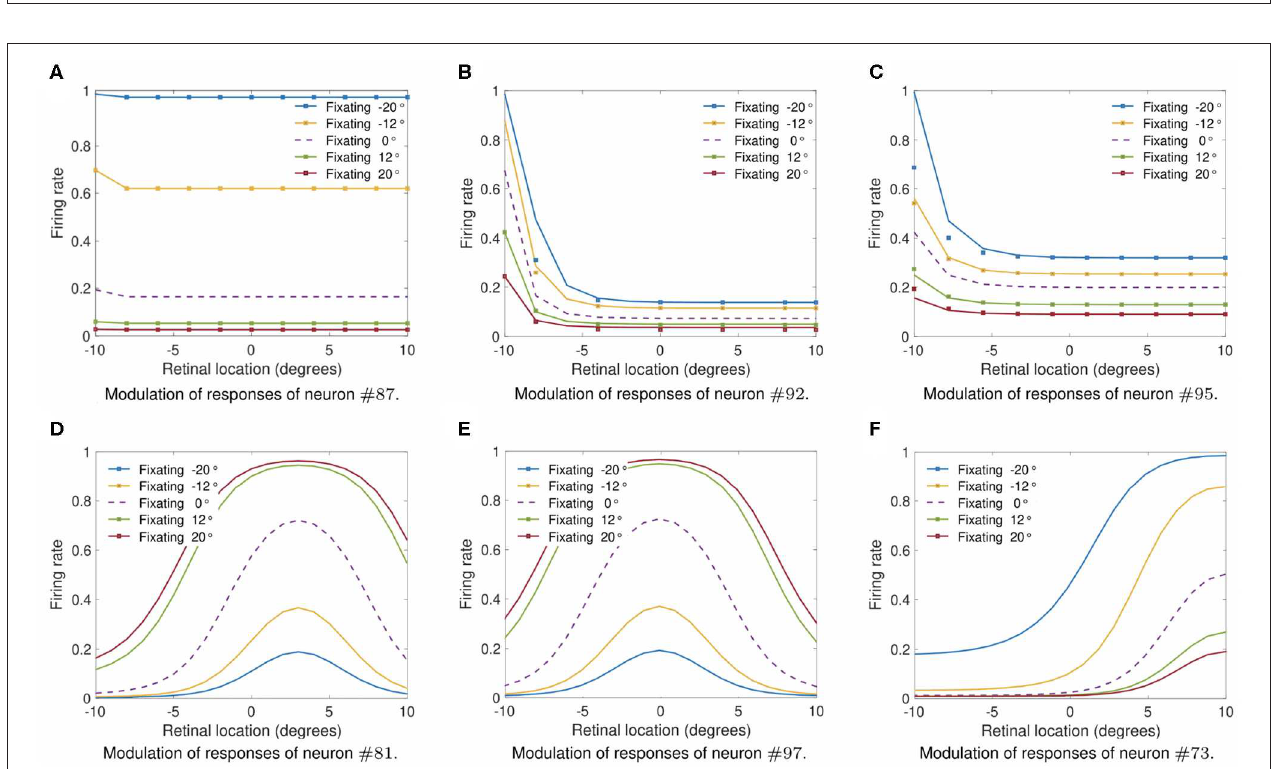
FIGURE 8 | responses from showing little activity (A,G,M,N) to presenting an approximately Gaussian response profile (B–F). The remaining subplots (H–L,O–R) show that training the model with greater values of ρ resulted in more sigmoidal response profiles. These simulations results show that the width of the eye position tuning curve has a large impact on the self-organization of the functional form of the output responses, with the profiles passing from peaked to monotonic as ρ increases from 10 ◦ to 25 ◦ for the majority of output neurons. The responses of neuron # 51, however, were not monotonic even for greater values of ρ . The values of the coefficient of determination R 2 in each subplot show how the width ρ of the tuning curve of the eye position neurons affected the degree of linearity of the self-organized output responses. The values of R 2 were only calculated when the output neuron had significant activity for a range of eye positions after training.